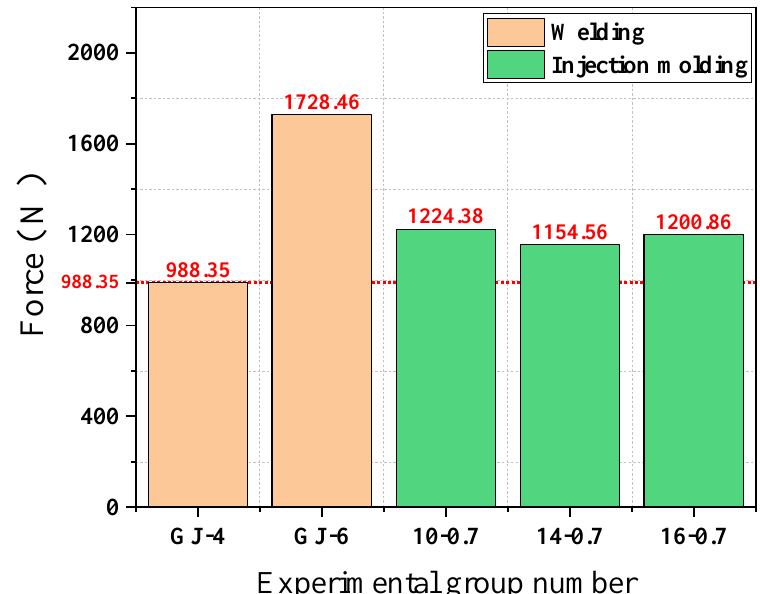
Figure 7. Comparison of node strength by test group.